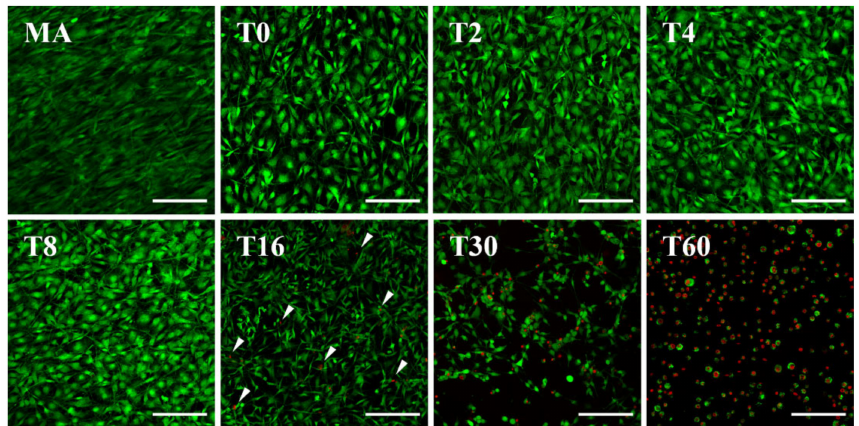
Figure 4. Fluorescence images for evaluation of the cytotoxicity of the surface by 24 h of cell culture using live (green) and dead (red, arrows in T16) stained osteoblasts (scale bar = 200 µ m).